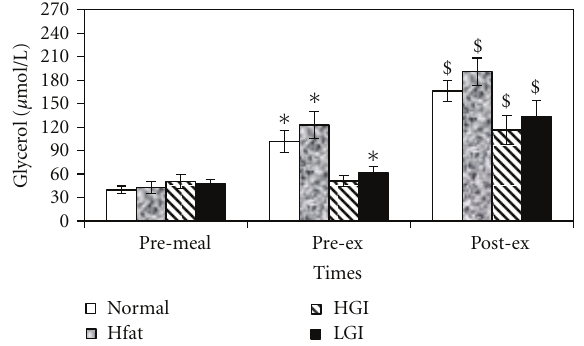
Figure 2: Mean ( ± SE) plasma glycerol concentrations at pre- meal, pre-exercise and, post-exercise for four trials. ∗ indicates significant with resting values and $ indicates significant di ff erence with postprandial